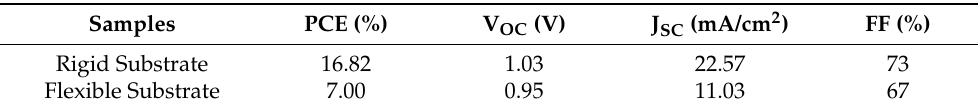
Figure 7. J–V curves for perovskite solar cells (reverse scanning) prepared on two substrates. Our concentration of SnO 2 colloid solution is 5 wt.%. Table 4. Parameters calculated from Figure 7. Our concentration of the SnO 2 colloid solution is 5